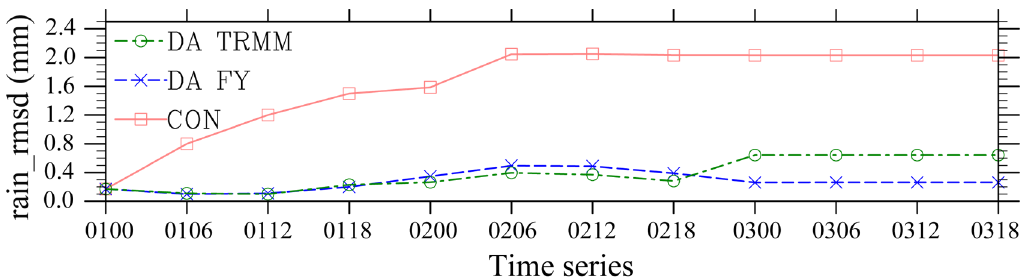
Figure 10. Six-hour accumulated precipitation root mean squared error between precipitation